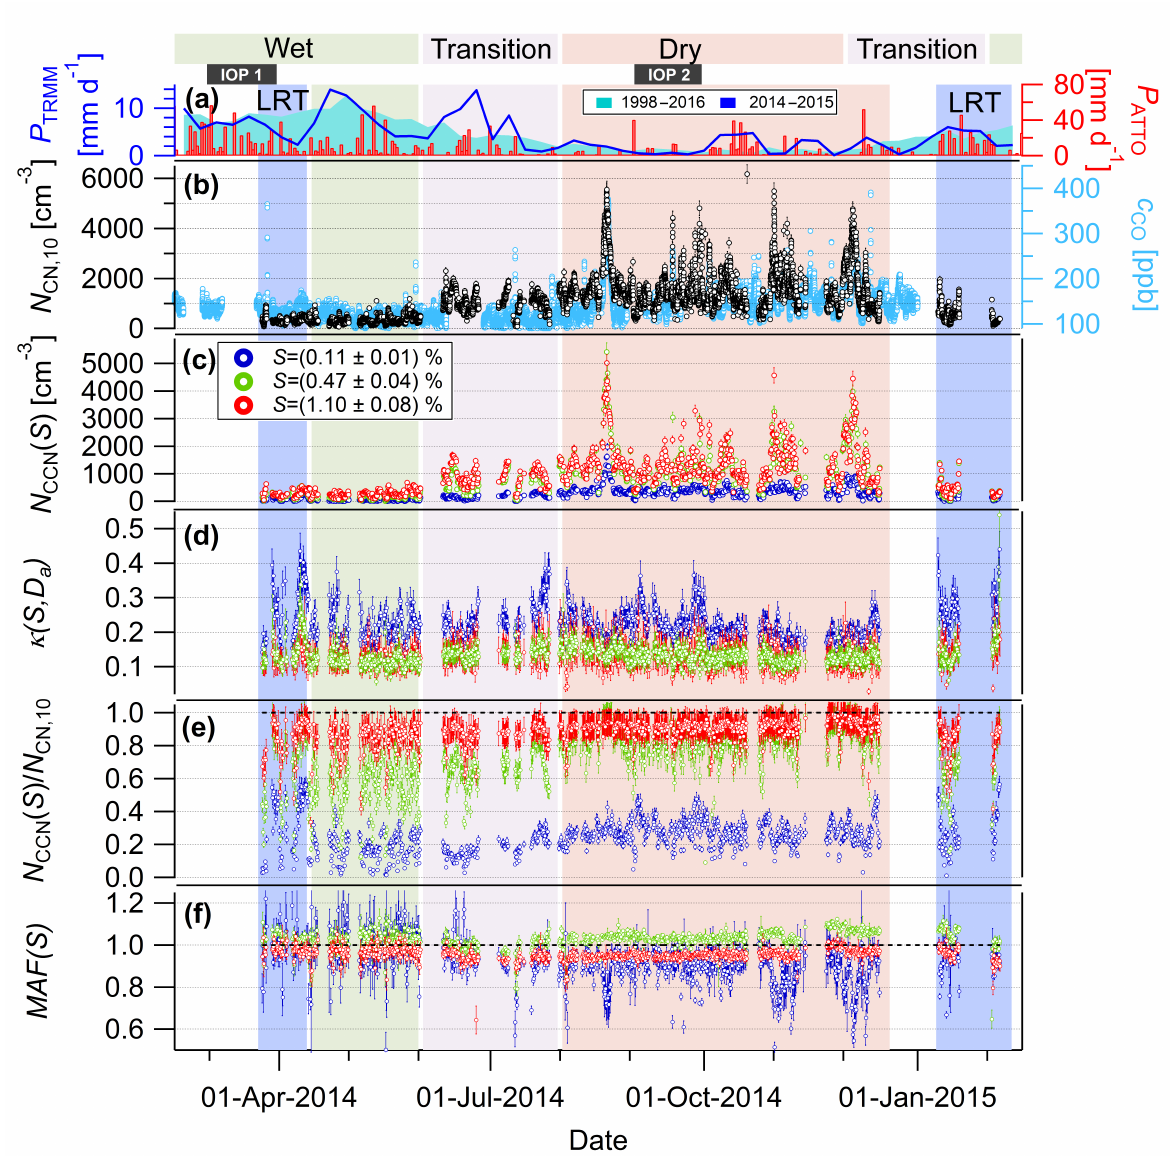
Figure 1. Seasonal trends in time series of precipitation rate P , total aerosol concentration N CN,10 , carbon monoxide mole fraction ( c CO ) , and CCN key parameters for three selected supersaturations S for the entire measurement period (shown in original time resolution). (a) Pre- cipitation rates from tropical rainfall measuring mission (TRMM) P TRMM and in situ measurements at the ATTO site P ATTO . The P TRMM seasonal cycles are derived from an area upwind of the ATTO site (59.5 ◦ W, 2.4 ◦ N, 54.0 ◦ W, 3.5 ◦ S), covering a long-term period from 1 Jan- uary 1998 to 30 June 2016 (aqua shading), and the period of the CCN measurements from 1 March 2014 to 28 February 2015 (blue line). (b) Time series of pollution tracers N CN,10 and c CO . (c) CCN concentrations N CCN ( S ), (d) hygroscopicity parameter κ ( S , D a ) , (e) CCN efficiencies N CCN ( S)/N CN,10 , and (f) maximum activated fraction MAF( S ). Three different types of shading represent (i) the seasonality in the Amazon atmosphere according to Andreae et al. (2015) (wet vs. dry seasons with transition periods, illustrated at the top of the graph), (ii) periods of IOP1 and IOP2 during GoAmazon2014/5, (iii) seasonal periods of interest in context of the present study as defined in Sect. 3.3 (shading in background of time